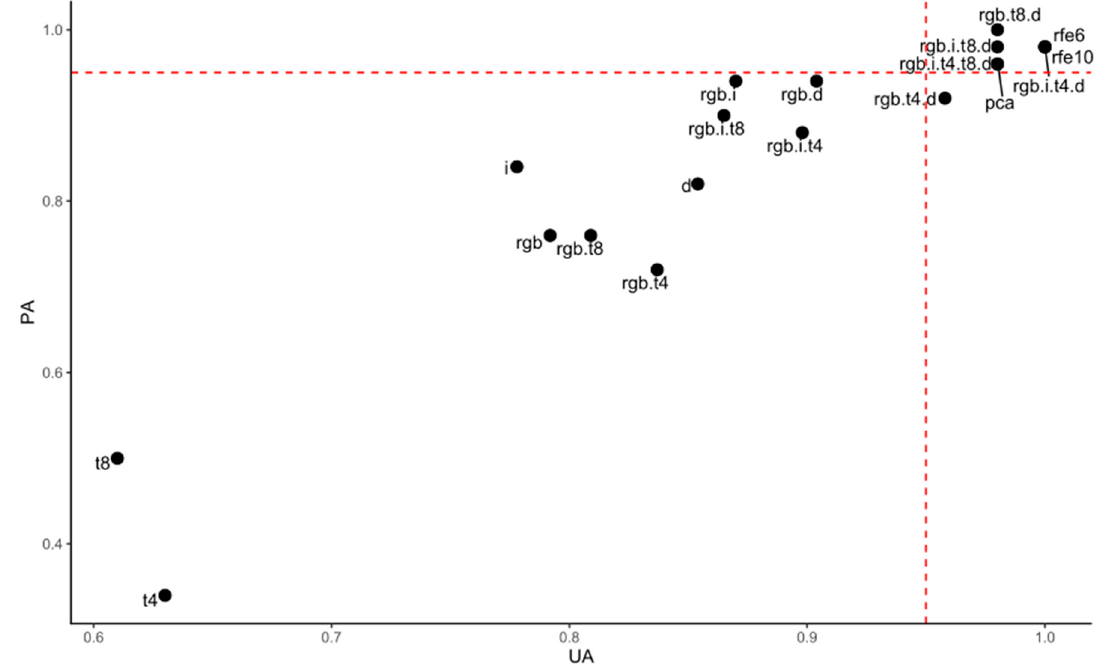
Figure 7. Classification accuracies on category level based on the maps generated by RF models and independent testing dataset (input variables: rgb: visible bands; i: RGB indices, t: texture information, pca: principal components, d: morphometric indices, rfe: selected variables with recursive feature elimination; dashed red line: accuracies >95%).